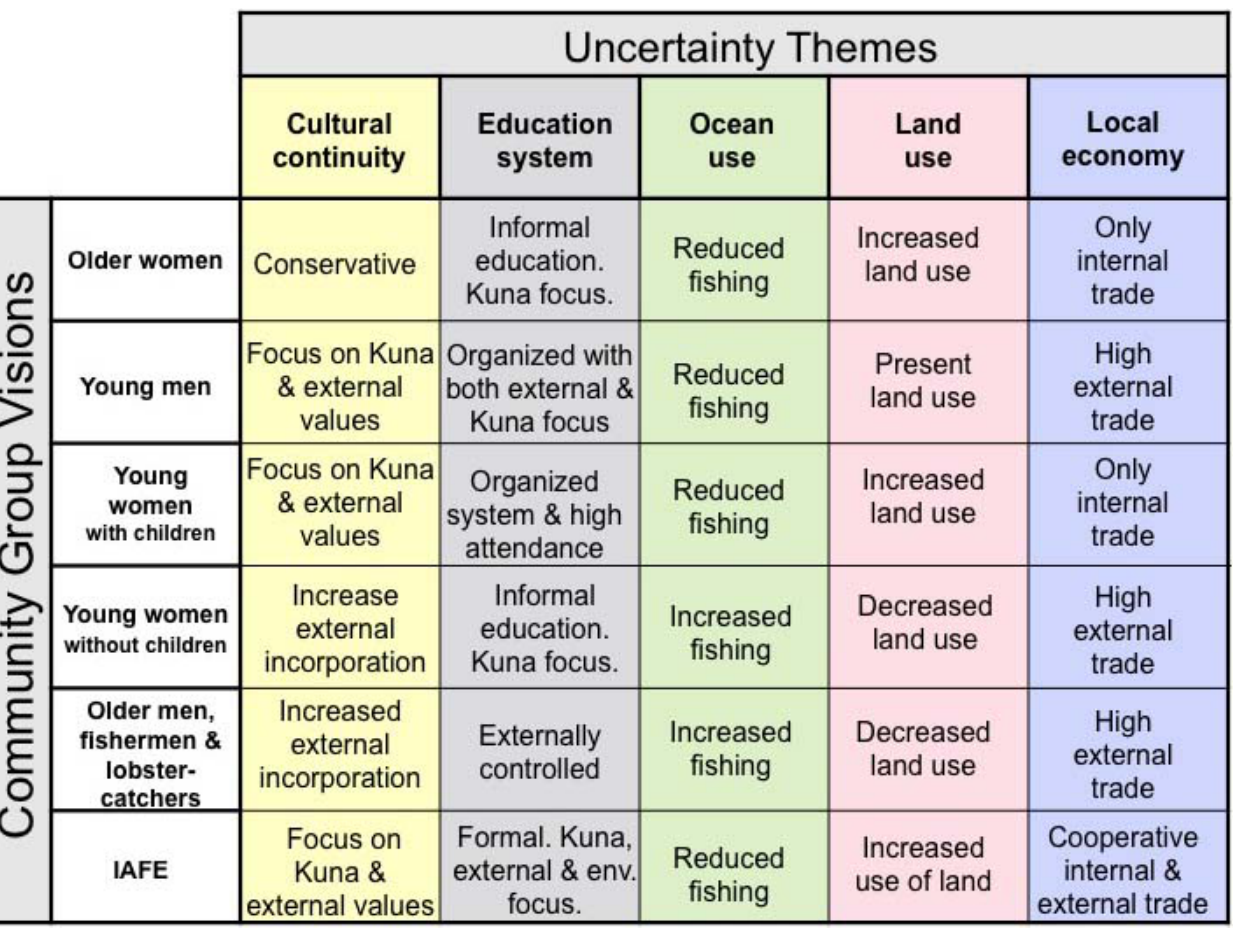
Fig. 3. The coding of visions in a Vision Comparison Table with uncertainty themes to later be linked to scenarios. IAFE = individuals with an advanced formal